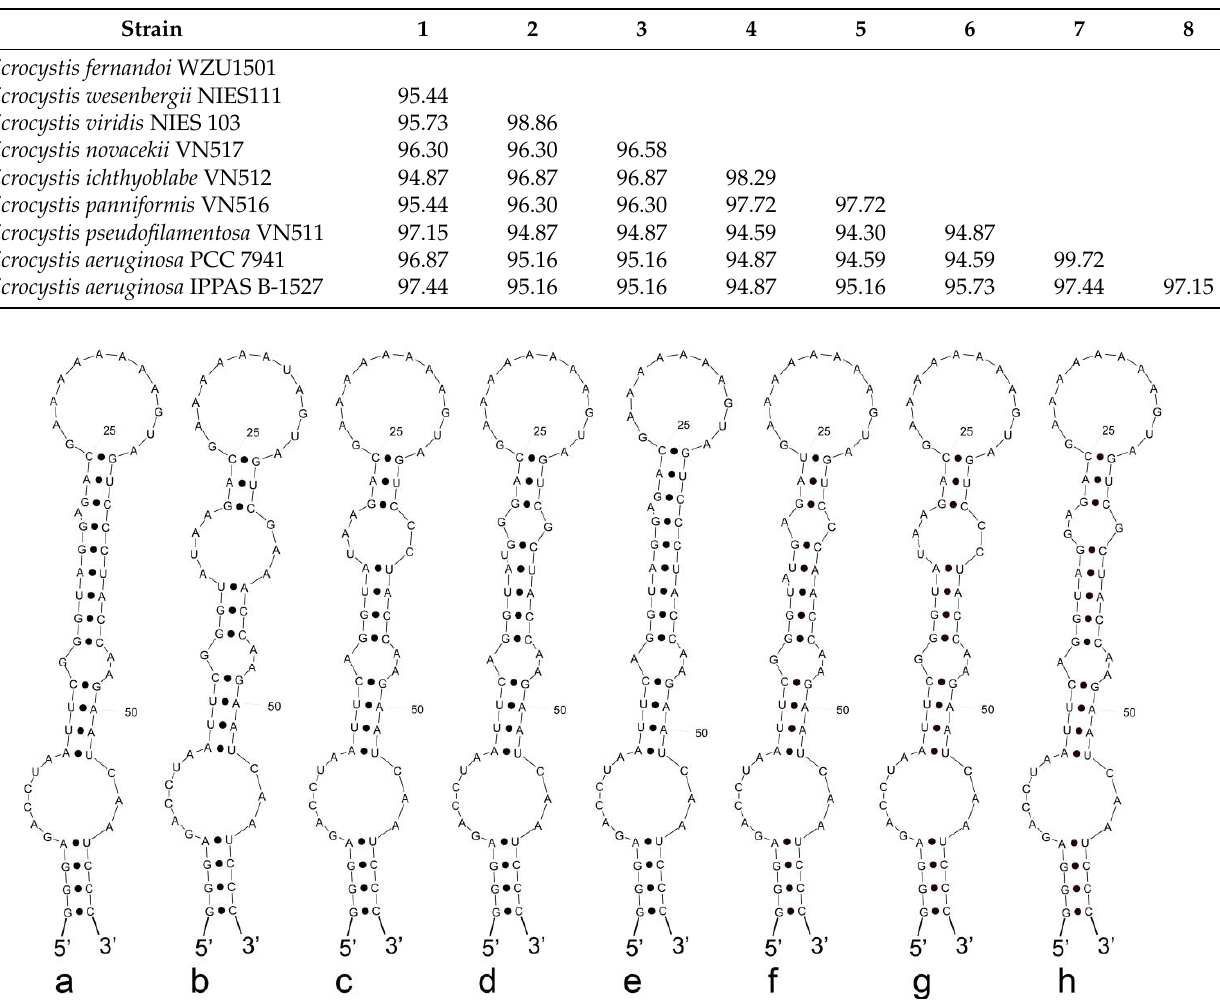
Figure 4. D1–D1’ helices of Microcystis . ( a ). WZU1501. ( b ). Microcystis wesenbergii NIES111. ( c ). Microcystis viridis NIES 103. ( d ). Microcystis novacekii VN517. ( e ). Microcystis ichthyoblabe VN512. ( f ).